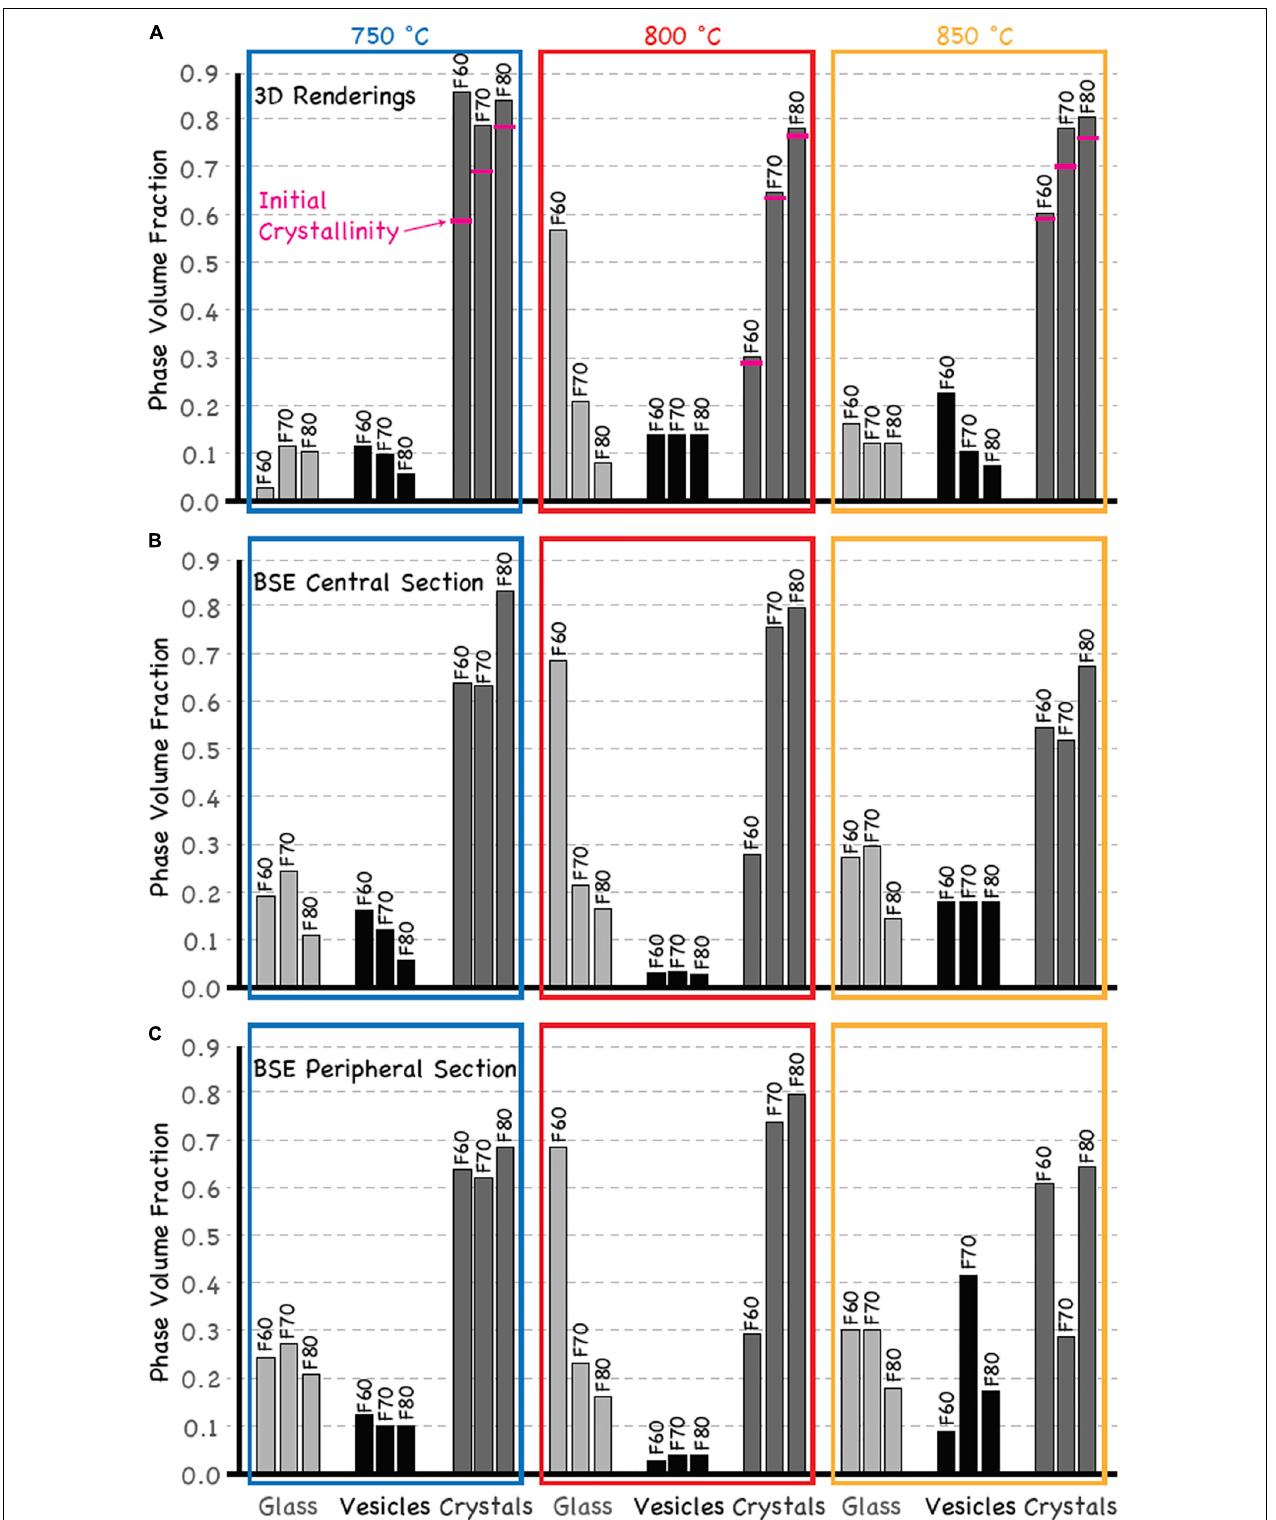
FIGURE 4 | Total volume fractions of phases: (A) in each tomographic 3D rendering, (B) in each BSE central section, and (C) in each BSE peripheral section of the experimental specimens. Volume fraction uncertainties (2 σ ) are 0.005, 0.002, and 0.002, respectively. Horizontal pink bars indicate initial level of crystallinity in the run products analyzed using X-ray tomographic